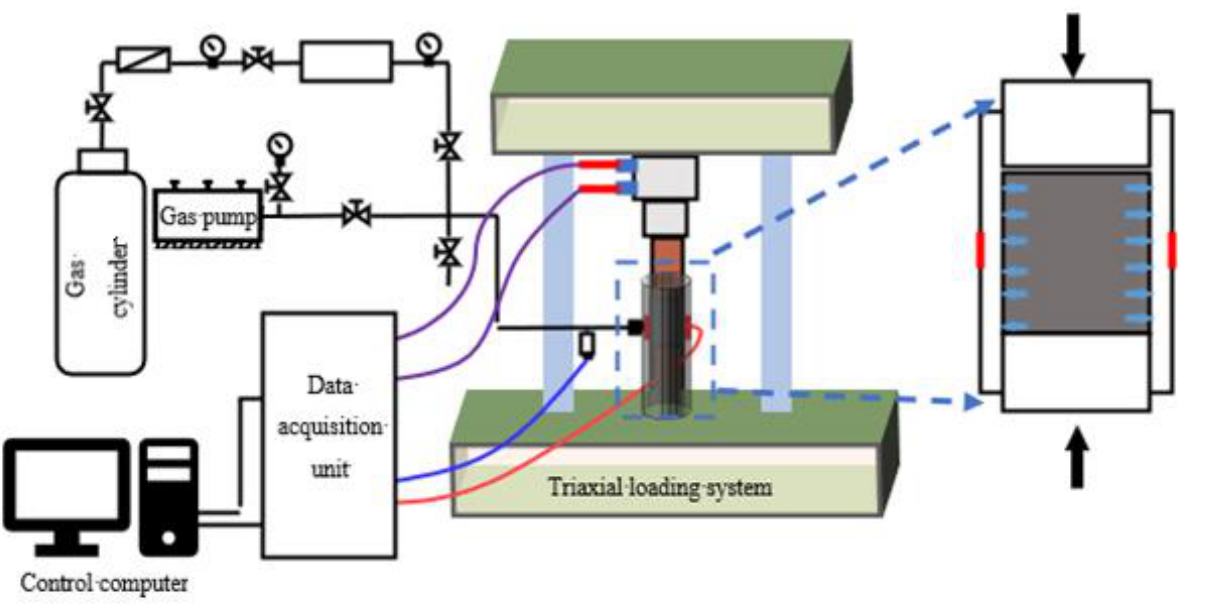
Figure 1. Structure diagram of test system.